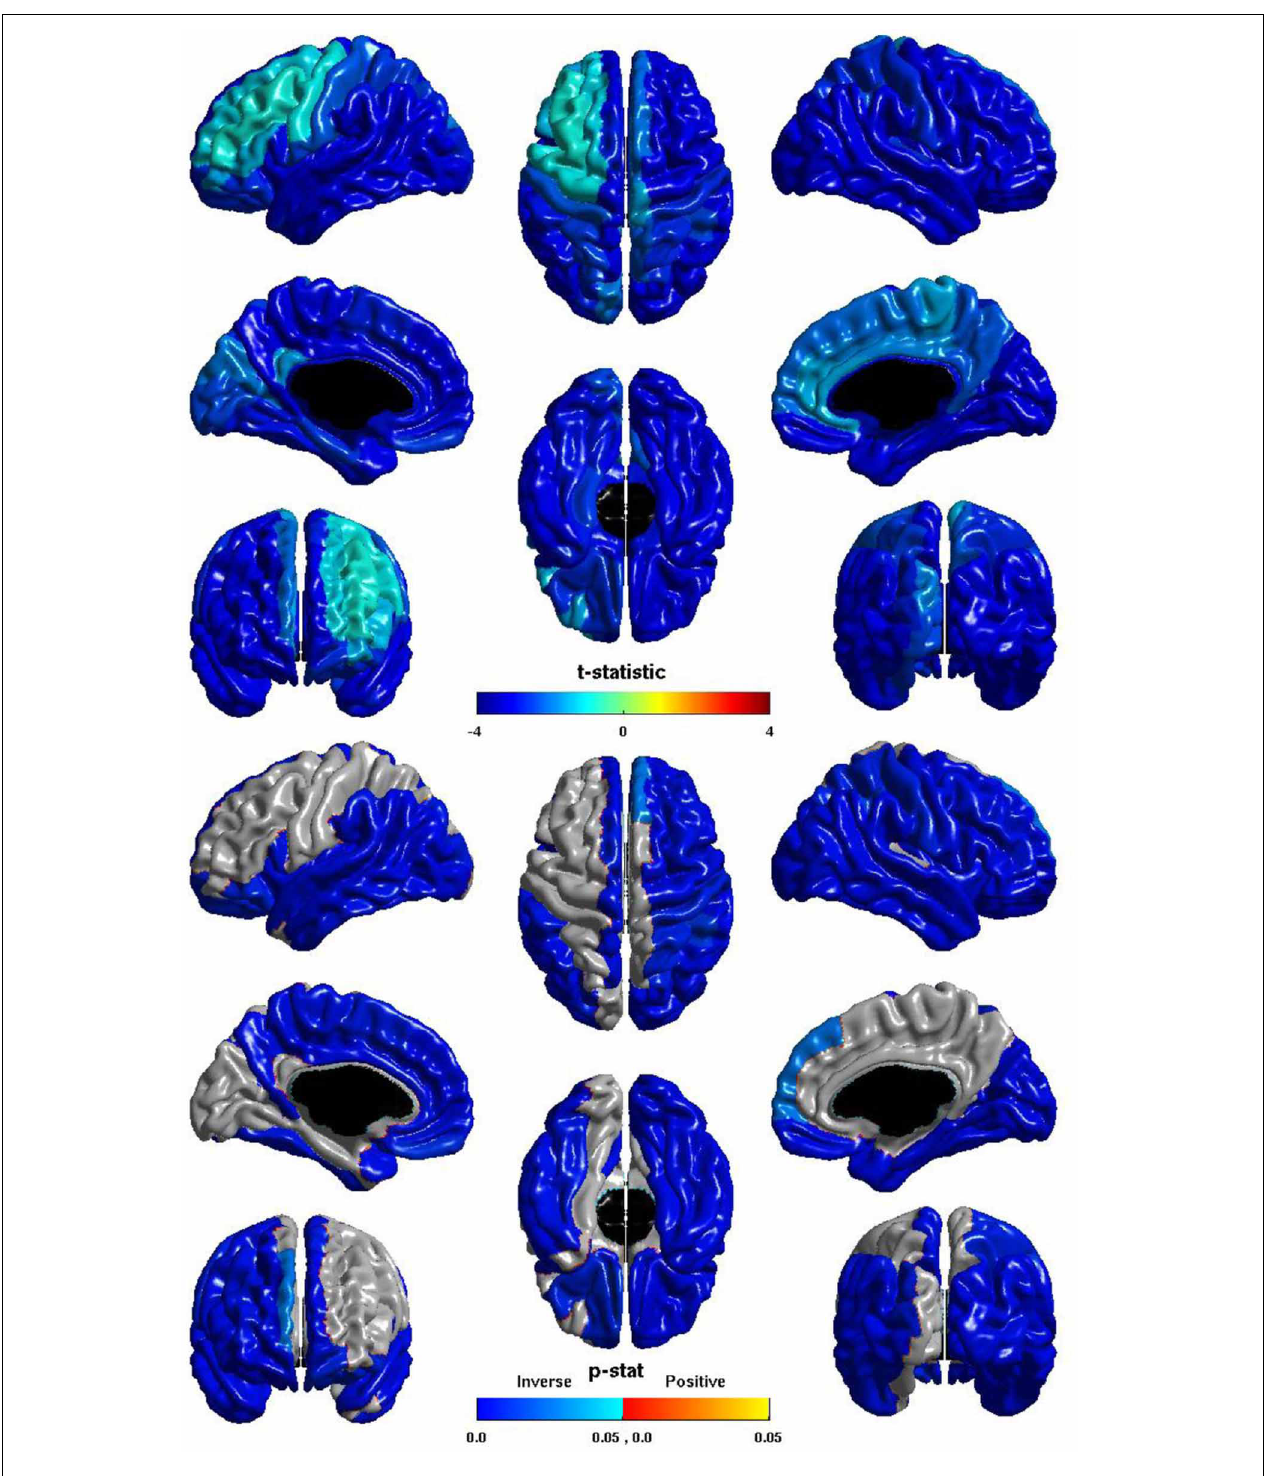
FIGURE 2 | Nodal Local Efficiency and ICV. The t -statistic (top) and the p -statistic (bottom) for the relation between ICV and nodal local efficiency in each region of the AAL atlas. A negative t -statistic represents decreasing nodal local efficiency with increasing ICV. The t -statistic is overwhelmingly negative. The p -statistic is FDR-corrected, and is blue where the inverse relation is significant, and orange where a positive relation is significant. No